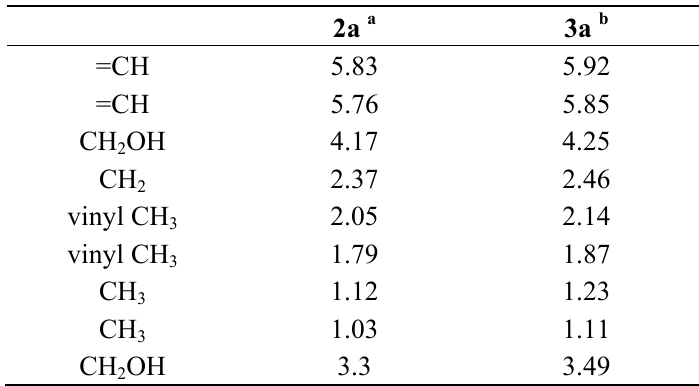
Table 2. 1 H-NMR of 2a and 3a